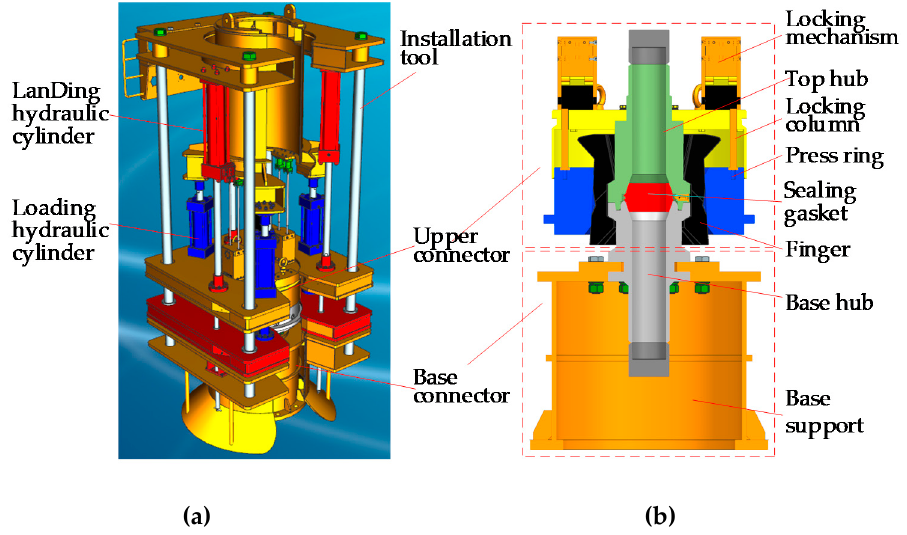
Figure 2. Integral structure of subsea collet connector. ( a ) Installation tool; ( b ) Connectors.